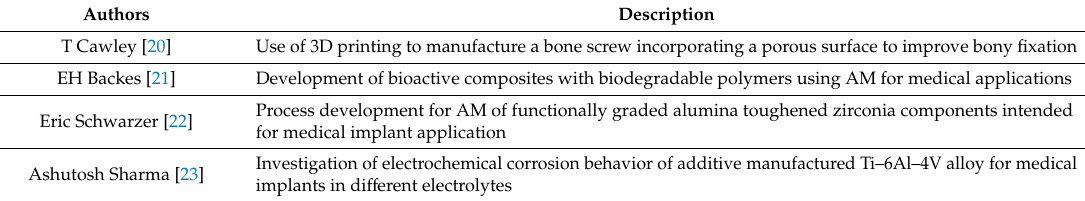
Table 1. Latest publications in the medical field using additive manufacturing.